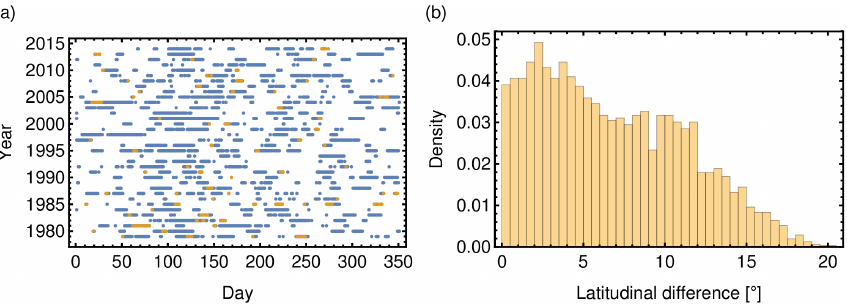
Figure 8. (a) Day–year plot showing days used for tuning (blue) and those days where Rikus’ latitude position is not within the range of latitudes found with Dijkstra’s algorithm (199 of 3122 data points, 6.4%) (b) Histogram of minimum latitudinal difference between the jet stream core found with Dijkstra’s algorithm and the mean latitude from Rikus’ algorithm, in degrees, for the polar jet stream.